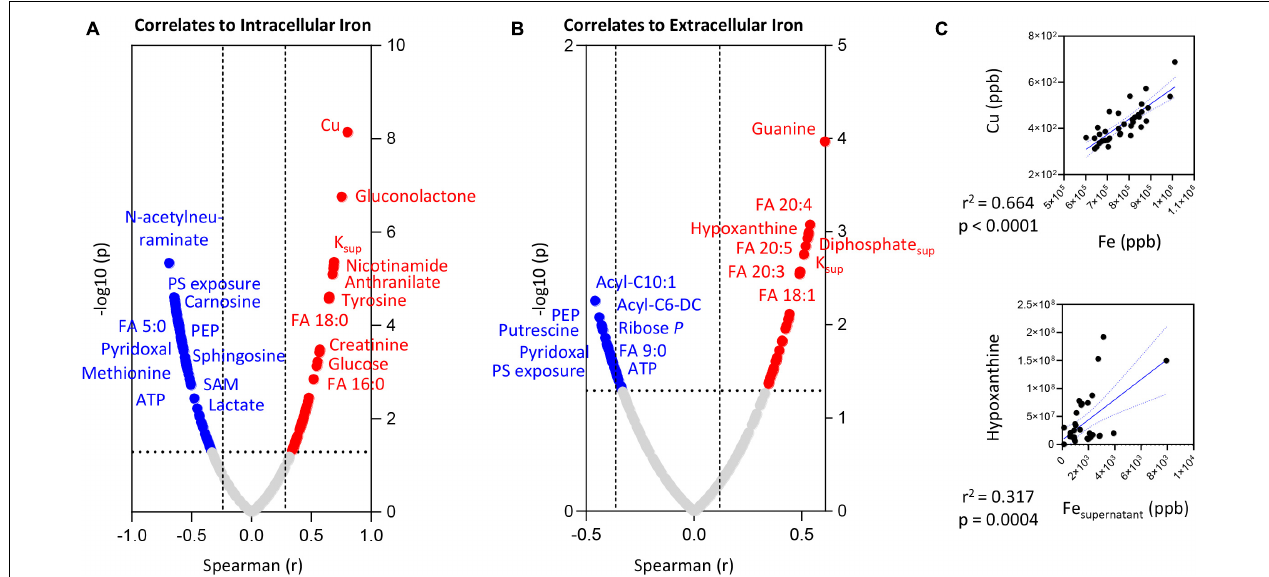
FIGURE 6 | Correlation of intracellular (A) or extracellular (B) iron (Fe) levels to RBC or superantant metabolites. In panel (C) , highlighted correlations curves for Fe and Cu (intracellular) and Hypoxanthine and Fe (supernatant).